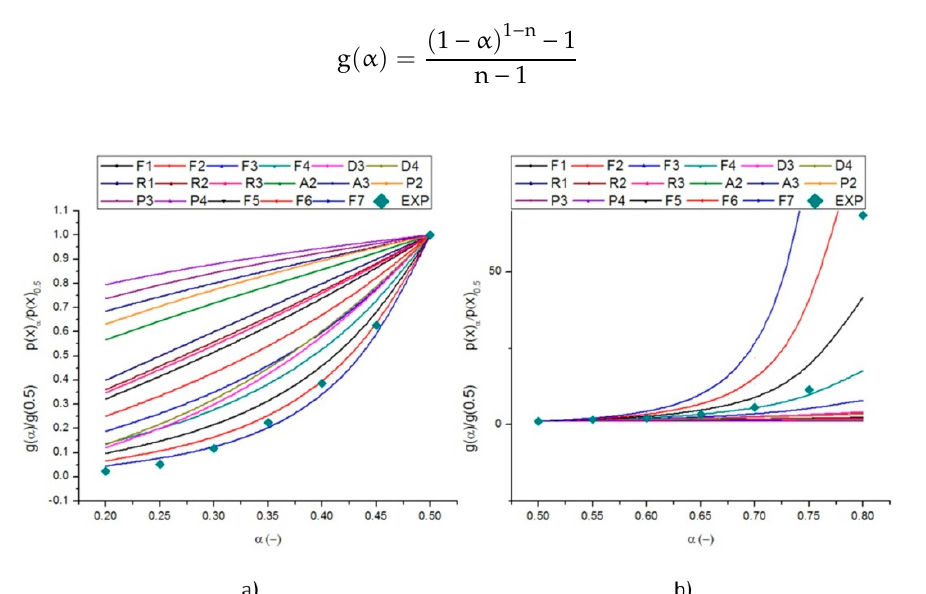
Figure 5. Theoretical and experimental master plots functions from ( a ) 0.2–0.5 and ( b ) 0.5–0.8 of conversion.